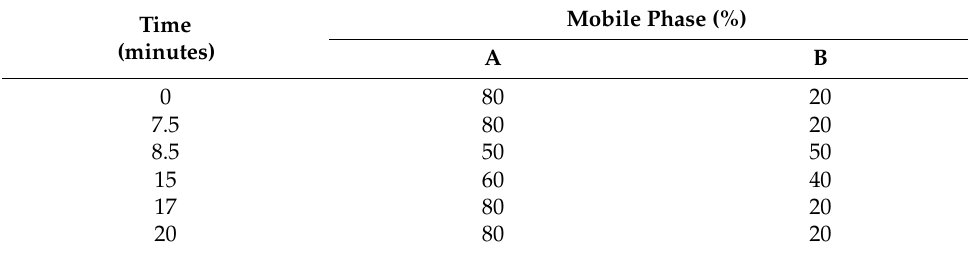
Table 1. HPLC method for